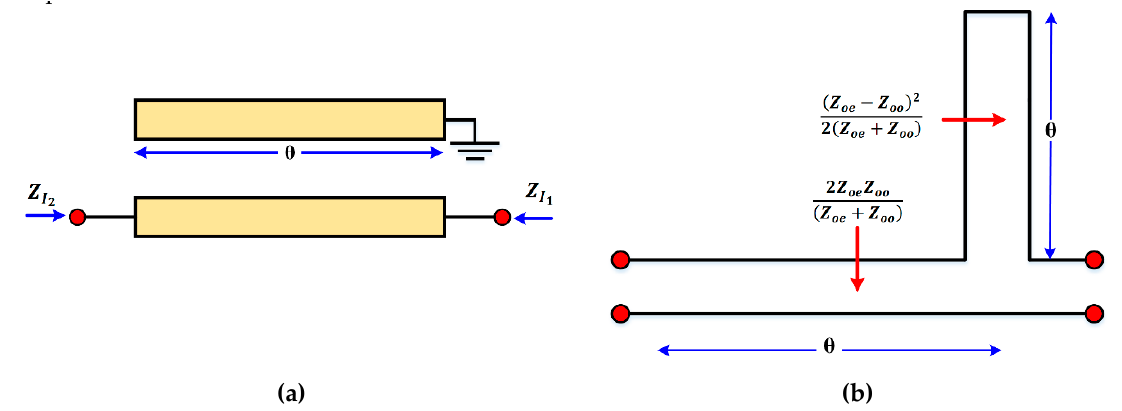
Figure 2. Coupled resonator ( a ) geometry and ( b ) equivalent circuit.